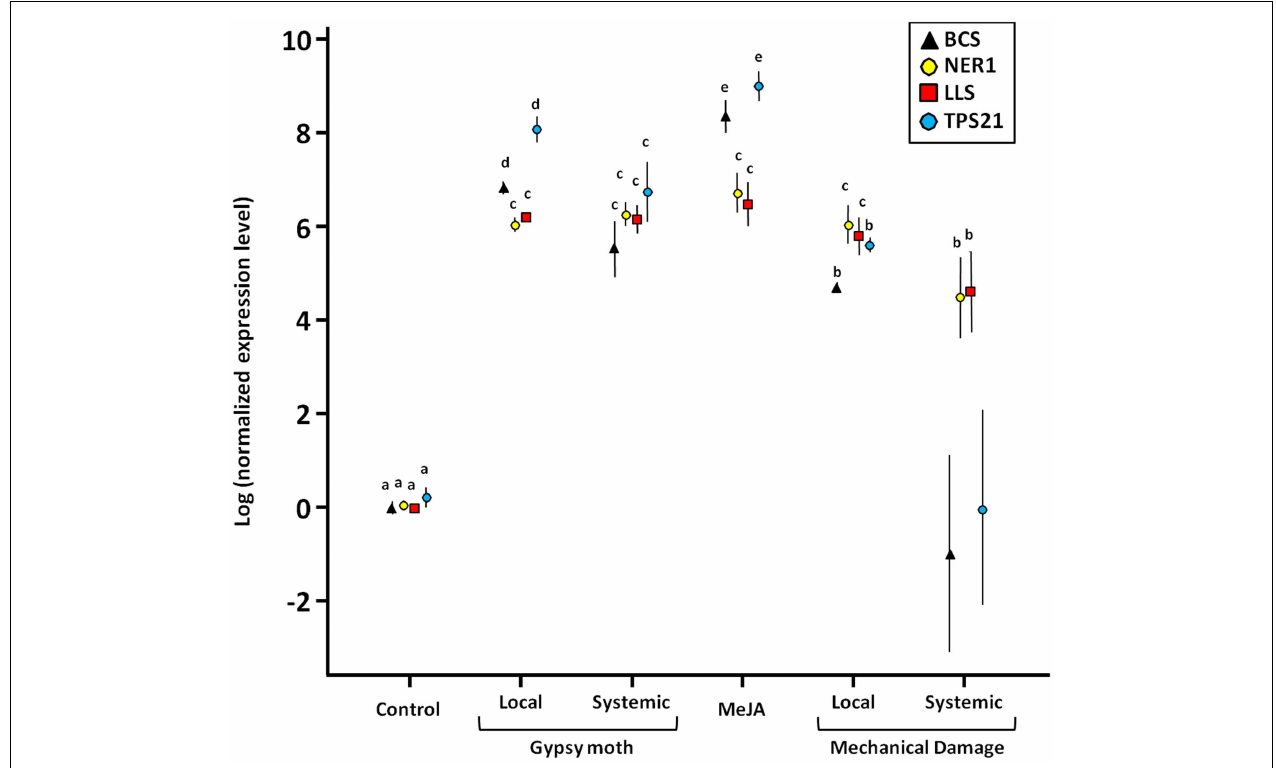
damage; Systemic = expression of undamaged leaves on damaged plants. Values are the mean ± 1 SE. Different letters indicate significant differences among treatments (adjusted for multiple comparisons); there are four sets of means separation letters, one for each gene. BCS and TPS21 values for “Mechanical Damage-Systemic” were not included in the statistical analysis due to excessively high